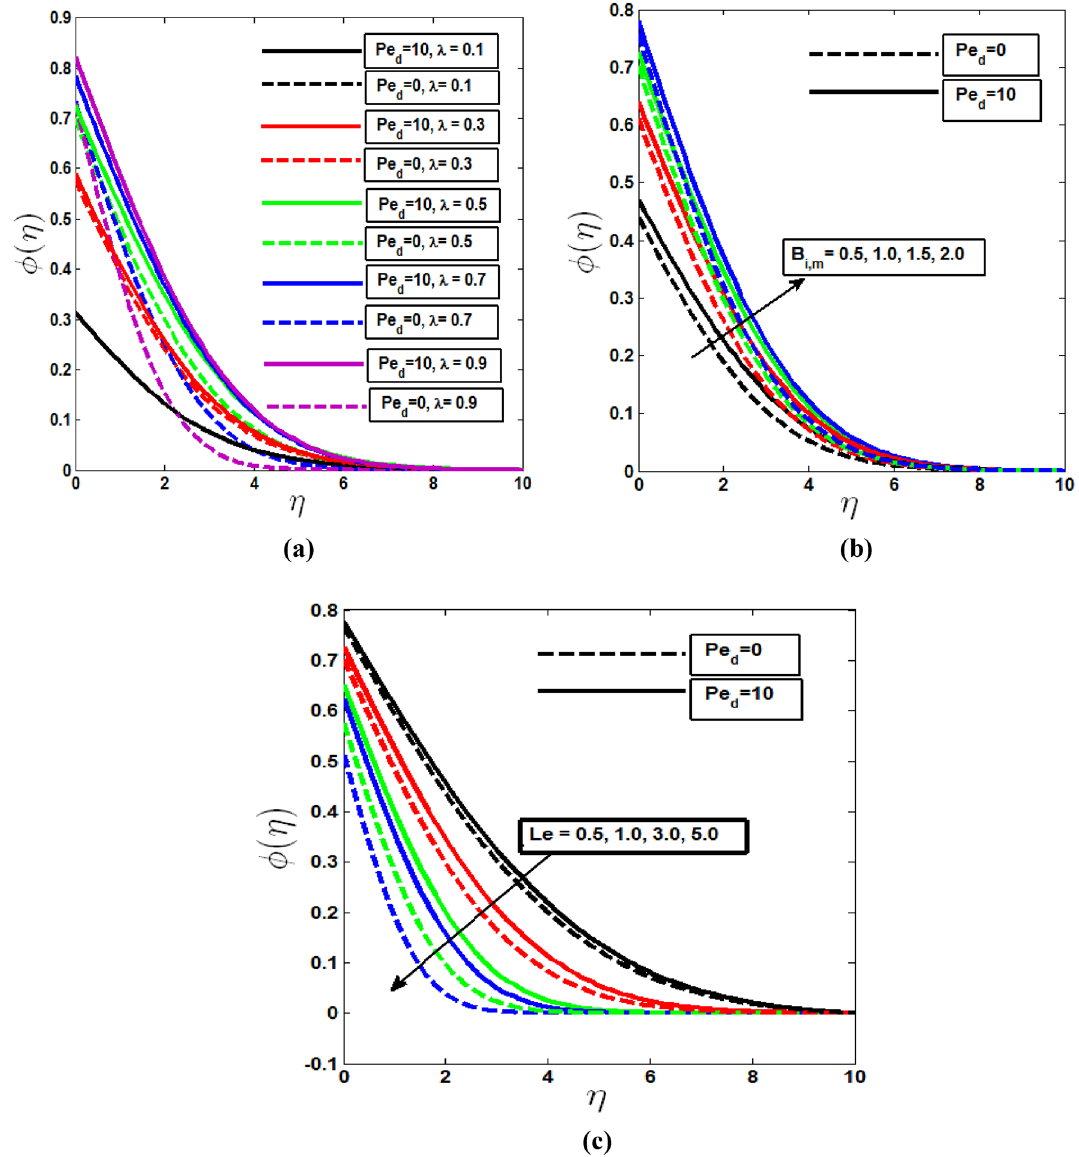
Figure 4. Concentration profile with the ( a ) variation of mixed convection parameter, ( b ) Biot number of mass transfer, ( c ) Lewis parameter Le in the presence and absence of solutal dispersion